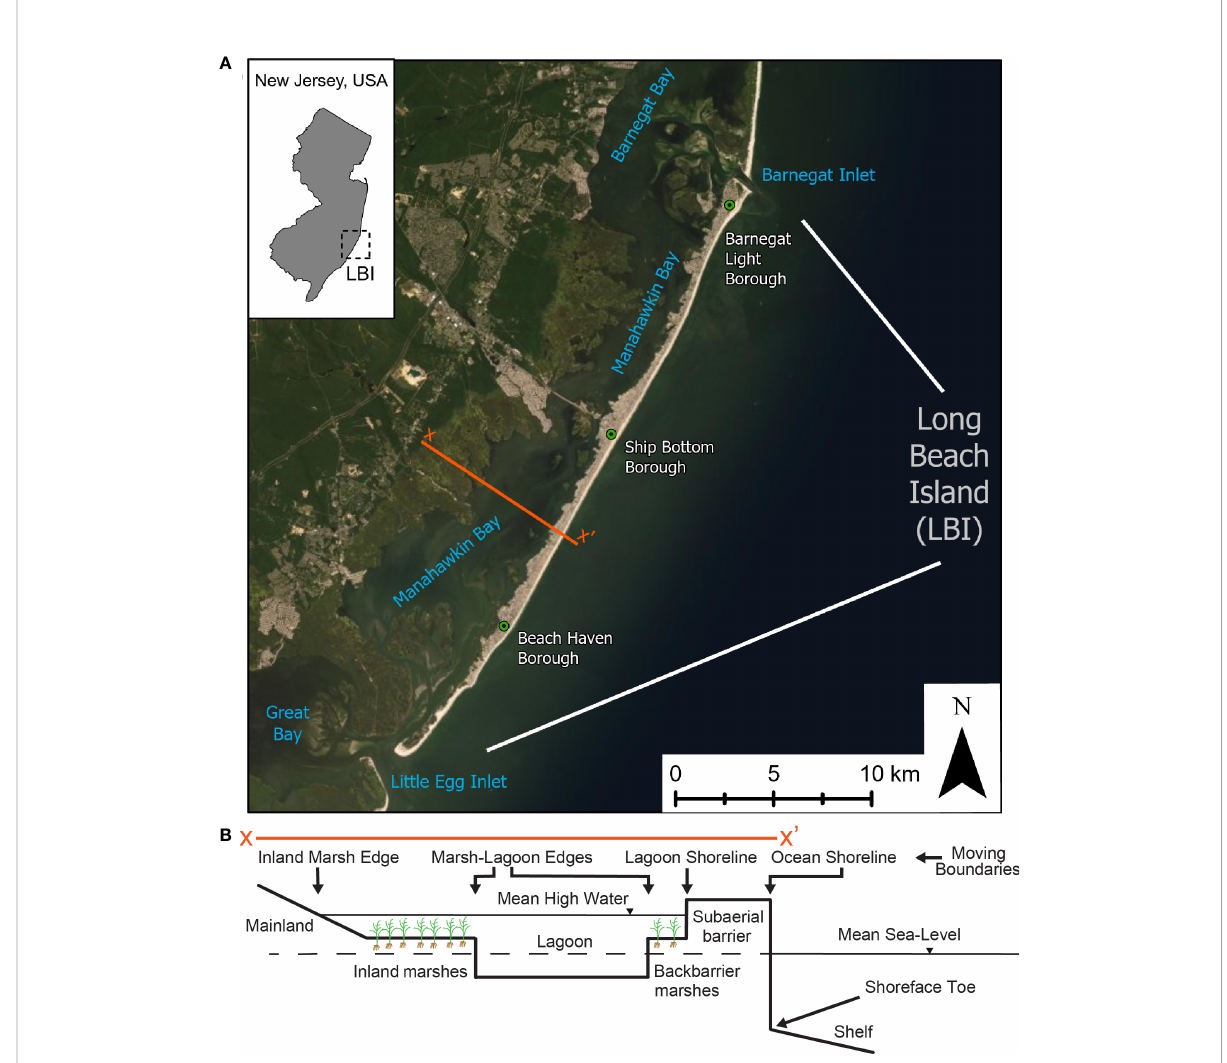
FIGURE 1 (A) Regional setting: Long Beach Island New Jersey. (B) Idealized cross-shore geometry of the barrier-marsh-lagoon system, including the key geomorphic moving boundaries. Base map image is the property of Esri and is used herein under license. Copyright © 2022 Esri and its licensors. All rights